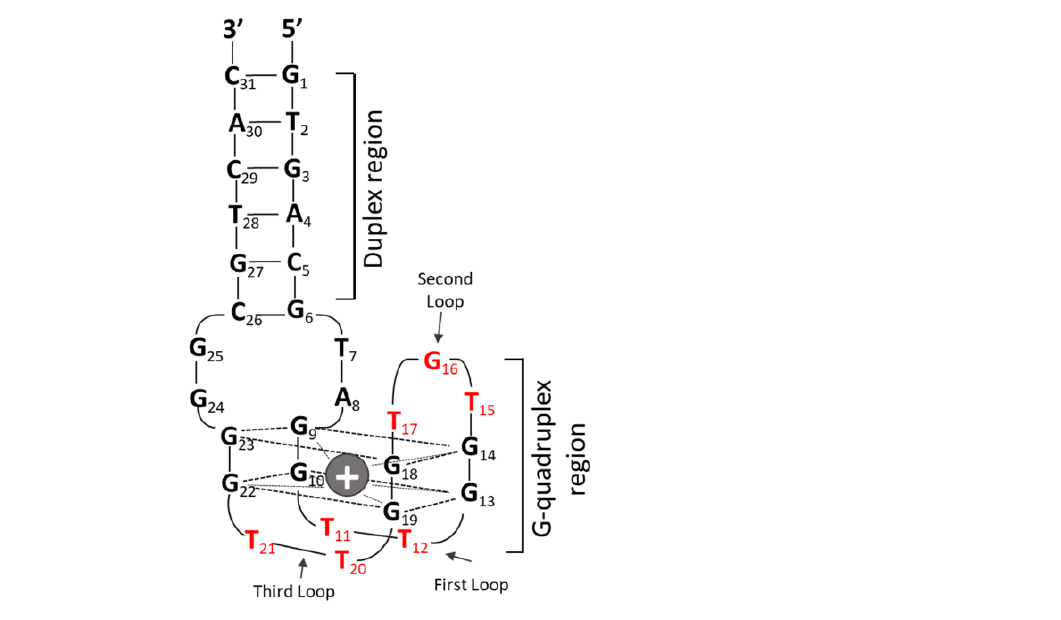
Figure 1. Structure of RE31 used as a scaffold to improve immunostimulatory function of CpG ODNs. The schematic represents the G0.0.0 design as the basic structure used in this study. The two G ‐ tetrads in G0.0.0 are separated by three loops (L). Red colors in the G0.0.0 structures indicate loop sequences, where T 11 and T 12 form the first loop, T 15 , G 16 and T 17 form the second loop, and T 20 and T 21 form the third loop. The loops were modified by insertion of CpG motifs.